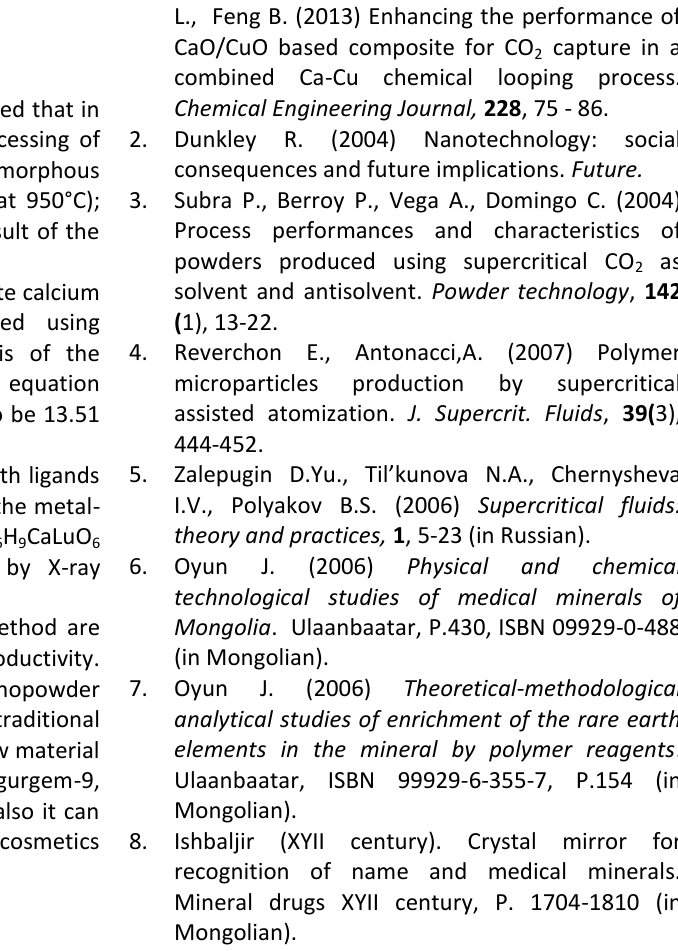
H CaLuO ) samples. The left image (a) is the CaO amor- 3 3 6 (at 950°C). The right part (b) shows a detail at higher magnification 2 after its temperature